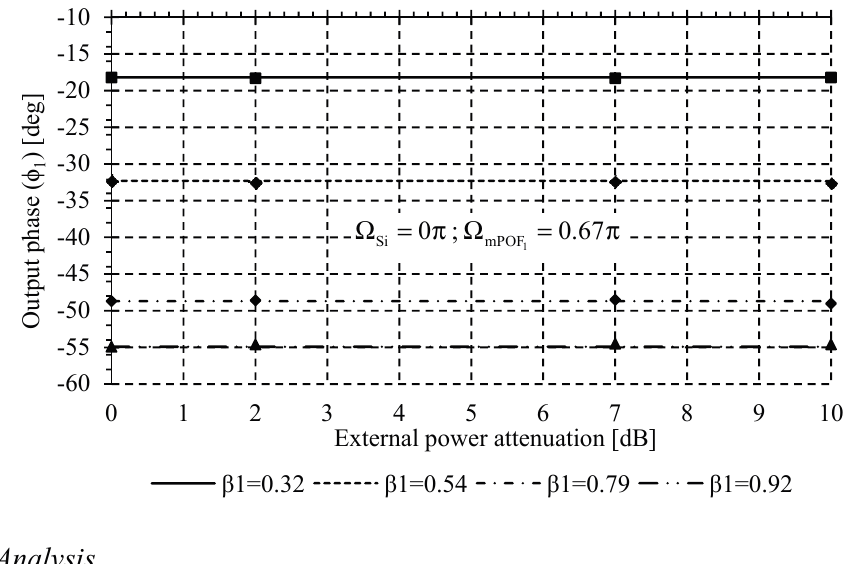
Figure 6. Output phase ϕ 1 self-reference test versus noise power fluctuations for different values of sensor losses at the remote sensing point addressed by λ mPOF 1 .